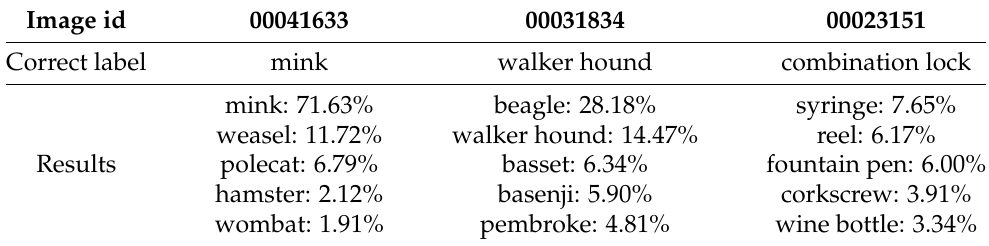
Table 6. Inference results in our reduced MobileNet V2 network (Images taken from the ImageNet 2012 validation dataset